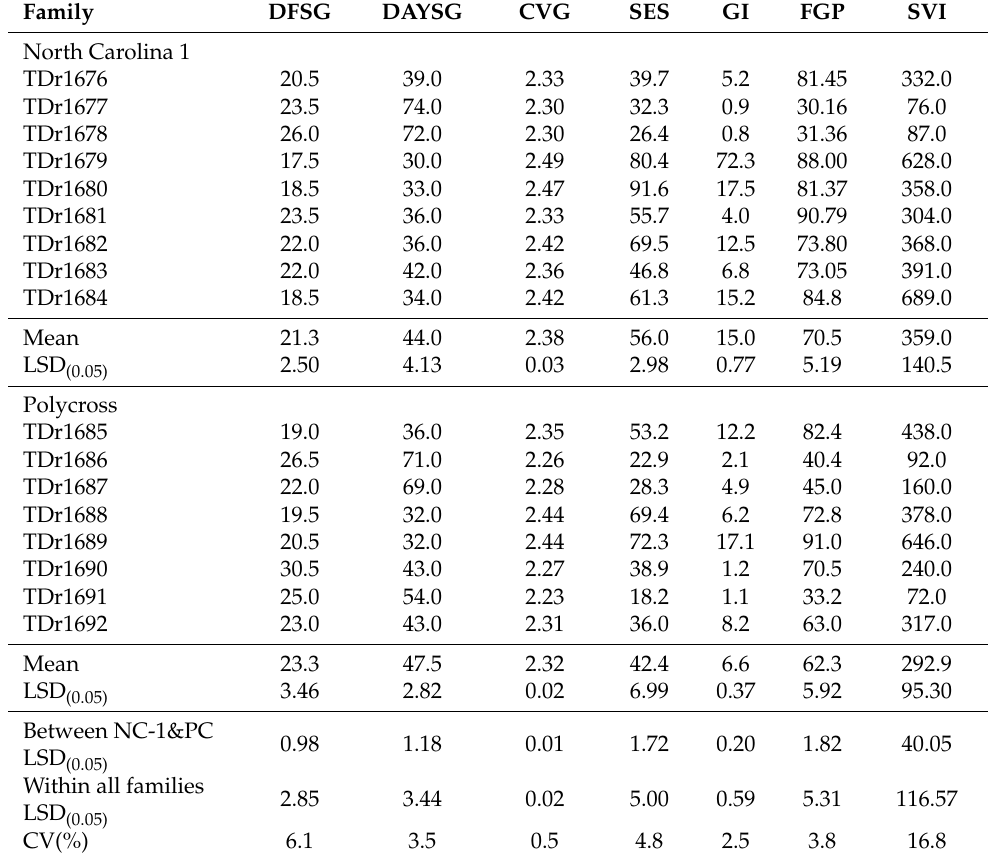
Table 2. Variation in seed germination attributes of white Guinea yam seed-families (crosses) gener- ated using North Carolina 1 (NC-1) and polycross (PC) designs.